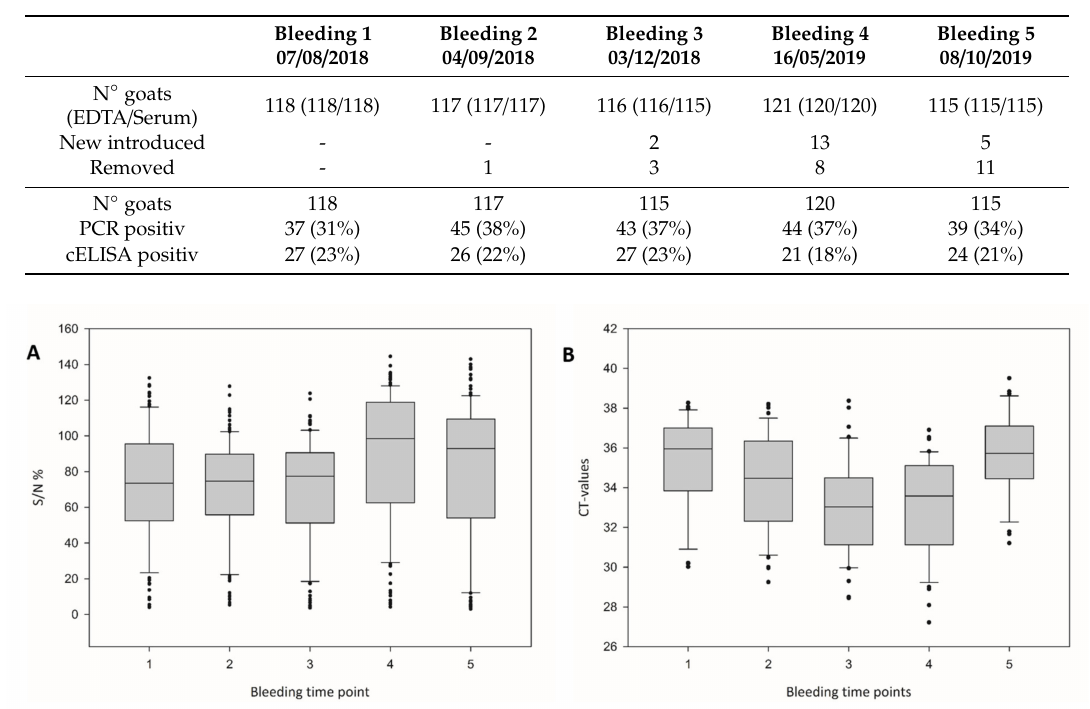
Figure 2. ELISA and PCR results of the 5 bleeding time points of the goat herd. The median values of the ( A ) reactivities of the ID.Vet cELISA in percent of negative control ( ≥ 50% is negative according to the manufacturer) and ( B ) the Cq values of the BTV-25 Mix13 Cq-values during the 5 bleeding time points of the goat flock are shown. The box and whisker plots show the median (broad central line), the interquartile range (box), the range of values (bars) and outliers